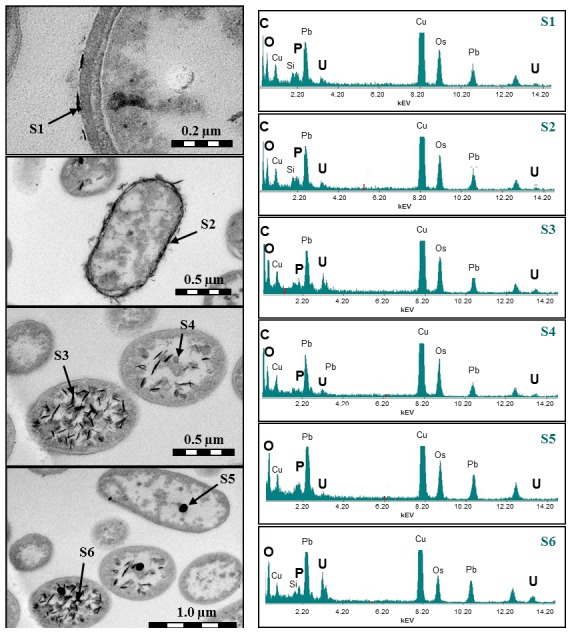
Transmission electron micrograph (left) of uranium precipitates deposited by the cells of Paenibacillus sp. JG-TB8 at pH 4.5 under oxic conditions.Energy-dispersive X-ray spectra (right) of the sample points (S1–S6) are marked with arrowheads.